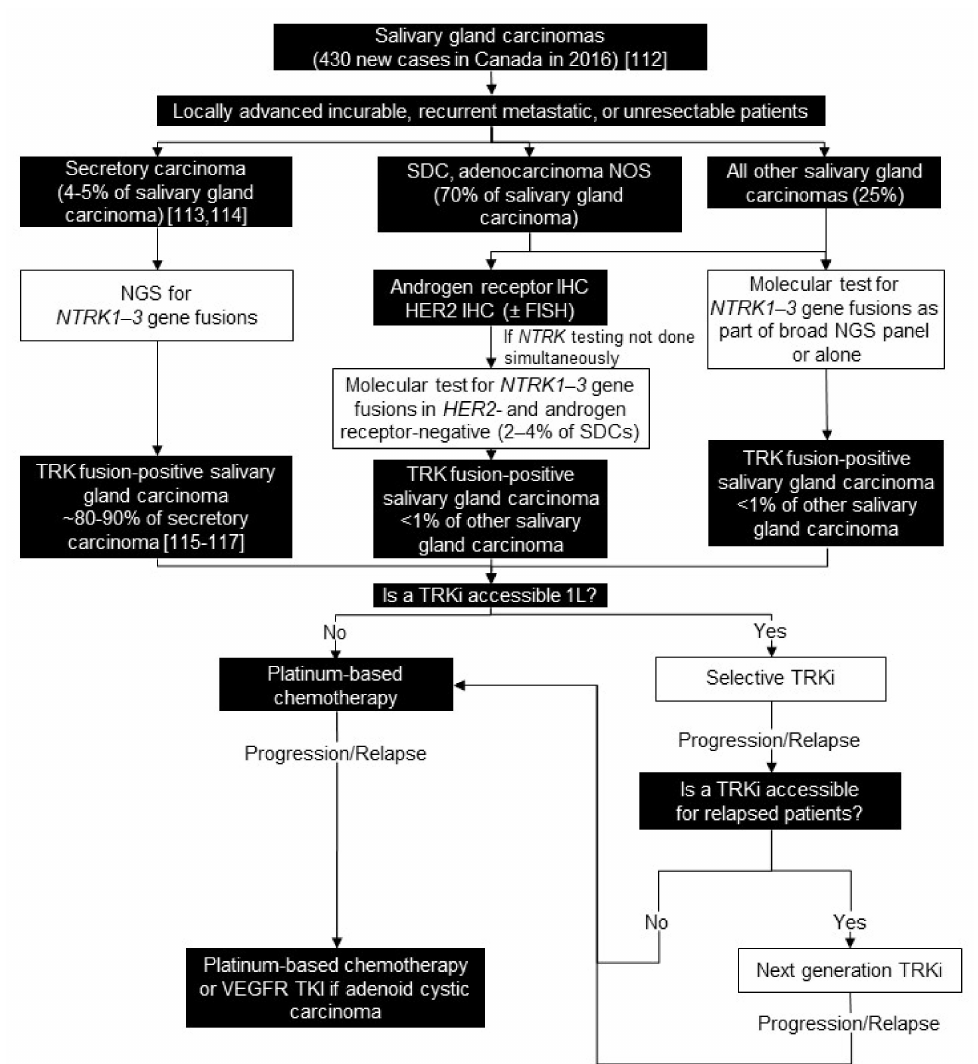
Figure 5. Biomarker testing and treatment for neurotrophic tyrosine receptor kinase ( NTRK) gene fusions in salivary tumours. White boxes with black outlines represent either NTRK gene fusion testing or treatment with a TRKi. Black boxes with white text indicate all other steps that do not include either NTRK gene fusion testing or treatment with a TRKi. FISH = fluorescence in situ hybridization; L = line; HER2 = erb-b2 receptor tyrosine kinase 2; IHC = immunohistochemistry; NGS = next generation sequencing; NOS = not otherwise specified; SDC = salivary ductal carcinoma; TRK = tyrosine